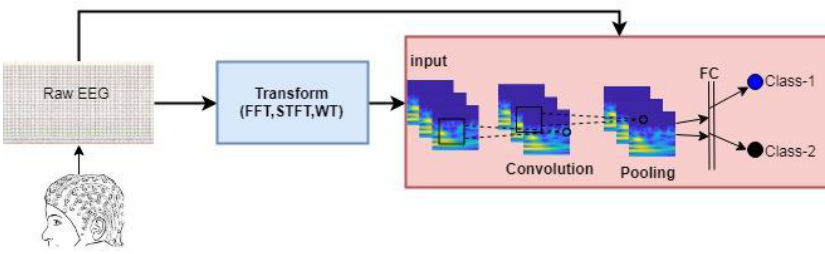
Figure 2. Steps in Deep Learning Methods. EEG: electroencephalogram, FFT: fast fourier transform, STFT: short time fourier transform, WT: wavelet transform, FC: f ully connected layer .